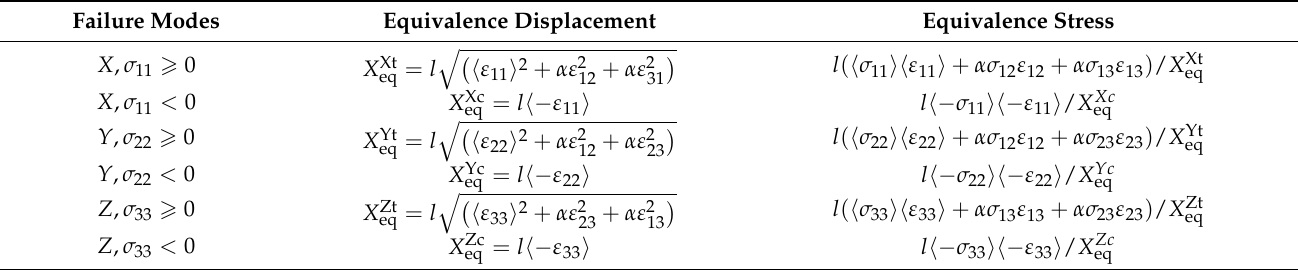
Table 1. The equivalence deformations and stresses under various failure